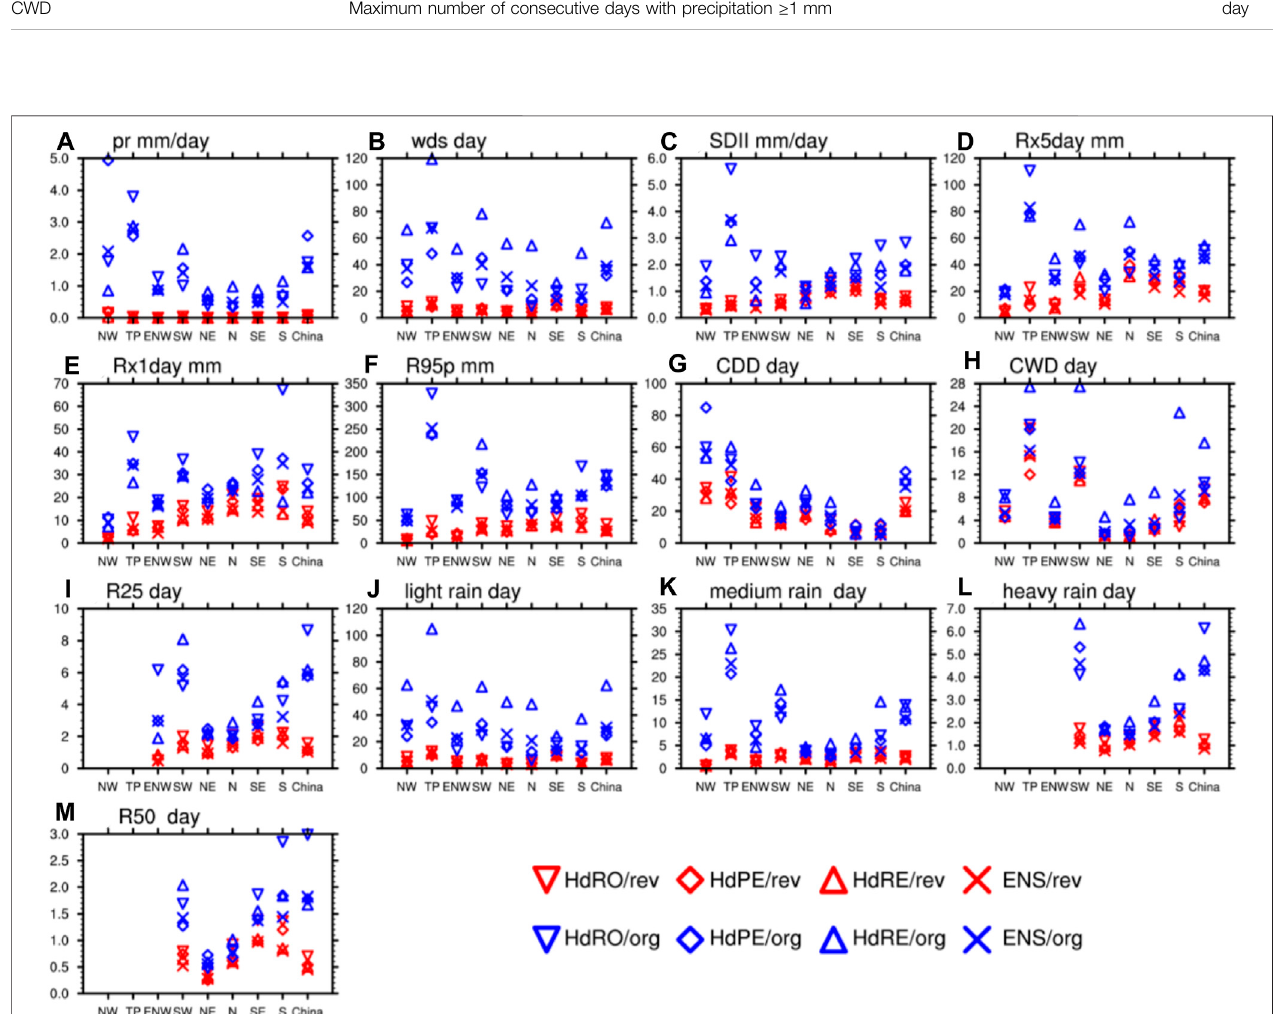
Frontiers in Earth Science |